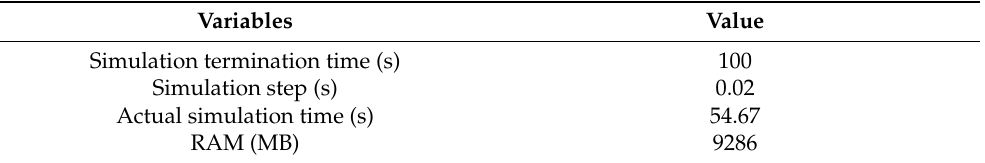
Table 3. The computational complexity of the method in driving scenario